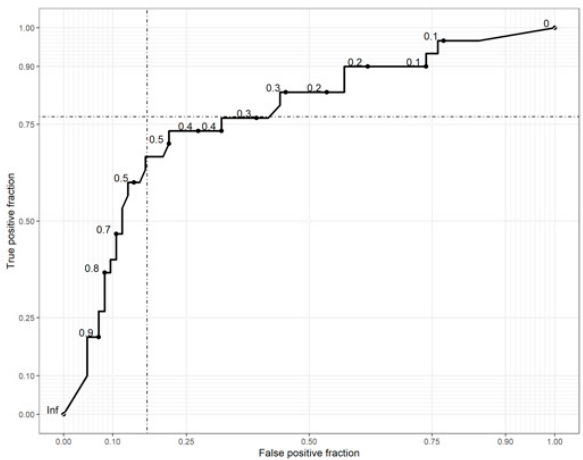
Figure 3. ROC curve of the entire dataset, using a unique threshold value for all the windfarms. The point defined by the intersection of the dashed lines is the result reported in Table 6.